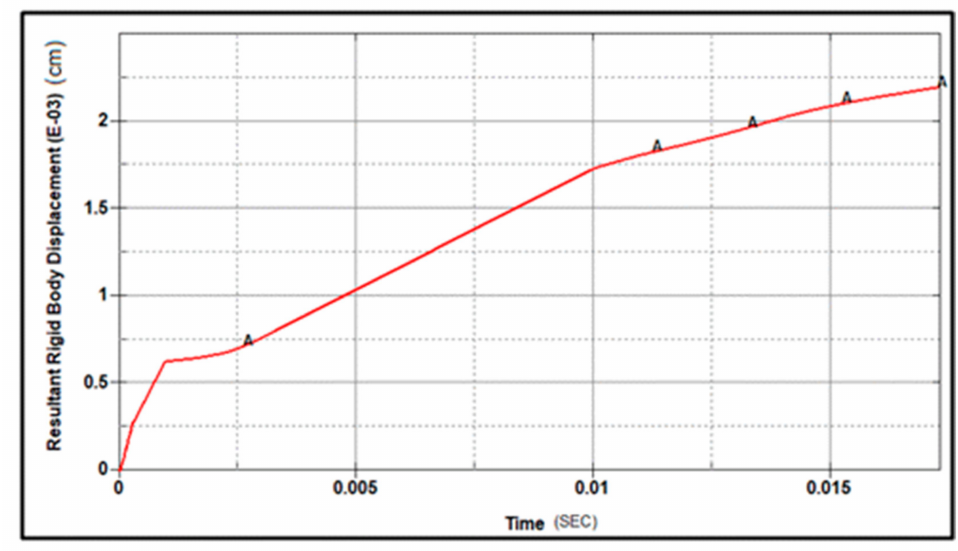
Figure 7. Displacement curve.